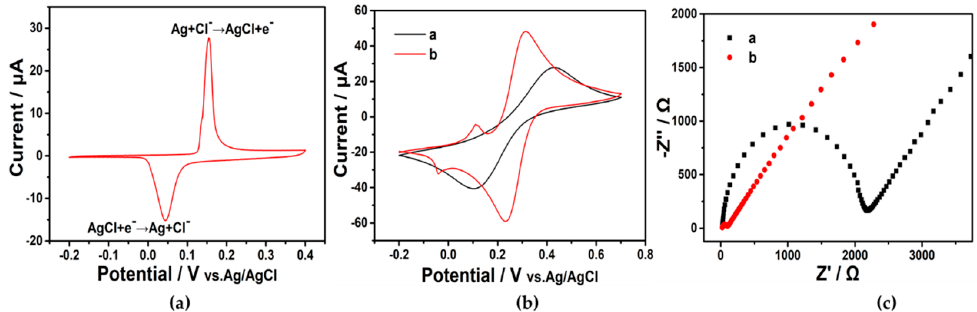
Figure 2. ( a ) CV of silver solid state phase transformation. Solution: 0.1 M NaNO 3 and 0.1 M NaCl. Modification of electrode: capture probe. Scan rate: 0.1 V/s. ( b ) CV and ( c ) EIS characterizations of HCR product without (a) and with (b) DNA metallization.